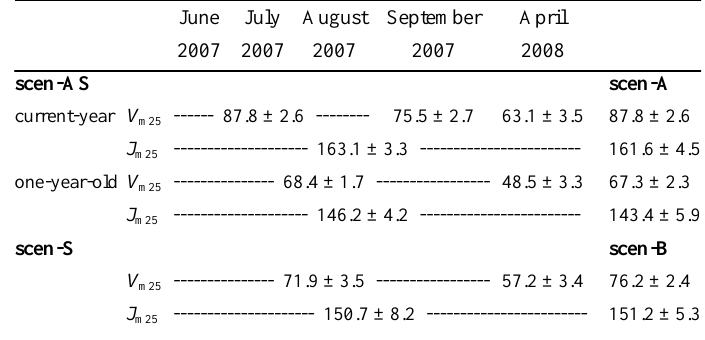
Table 4. Input values of carboxylation capacity at 25 ◦ C ( V m25 ; µmolm − 2 s − 1 ) and electron transport capacity at 25 ◦ C ( J m25 ; µmolm − 2 s − 1 ) (value ± SE) for the four scenarios. For the scenario including both seasonal and needle age-related variation (scen-AS) and the scenario including needle age-related variation only (scen-S), values between dashed lines are obtained from pooling the measure- ments from the consecutive sampling dates underscored by the dashed lines and are constant over period between the consecutive sampling dates. Values between non-pooled consecutive sampling dates are linearly intrapolated. For the scenario including needle age-related vari- ation only (scen-A) and the scenario omitting both seasonal and needle age-related variation (scen-B), values are based on measurements from July and August 2007 only.